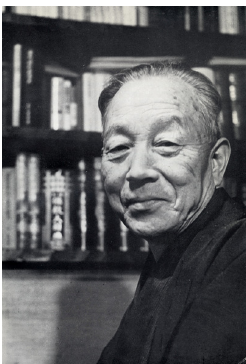
Figure 1. A portrait of Tetsuro Watsuji (Photo by Tanuma, Source: